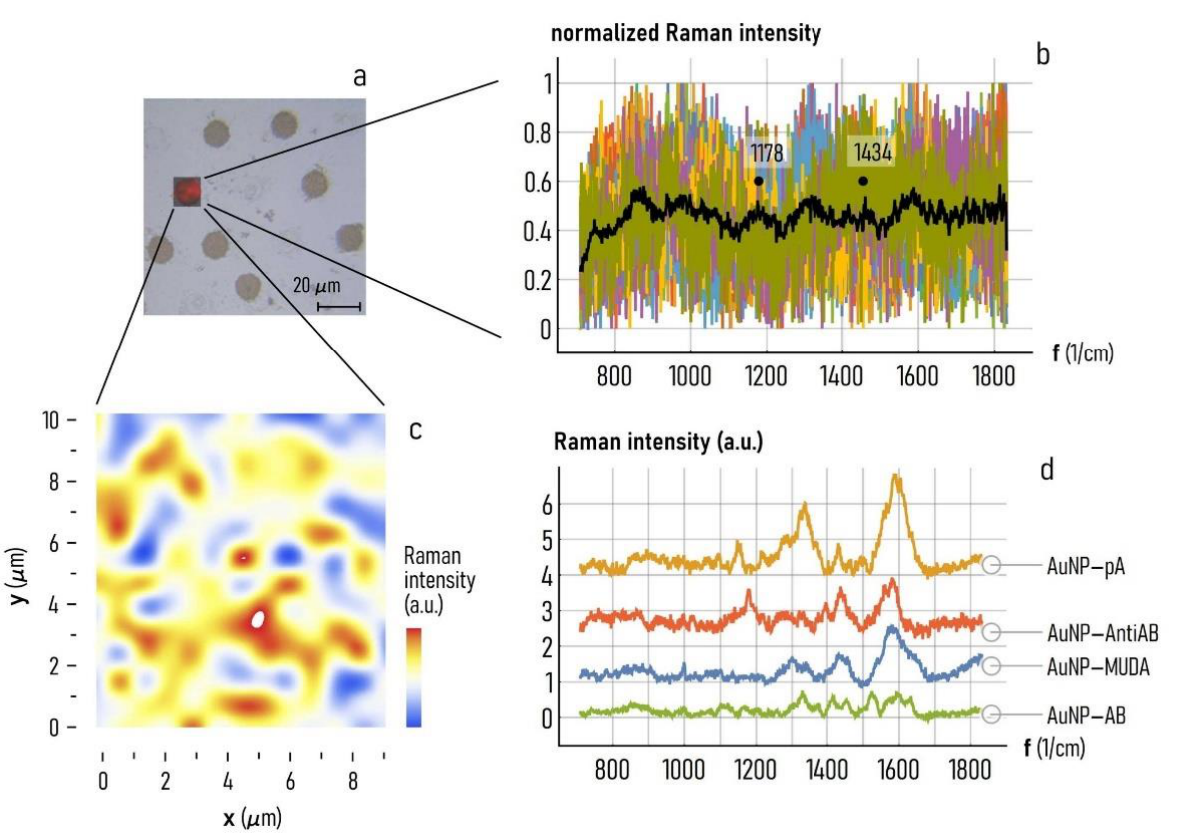
Figure 6. ( a ) Optical image of AuNP array template, analyzed by Raman spectroscopy. ( b ) Raman spectra collected during a mapping analysis. The averaged spectrum (black) evidence the two significative peaks at points 1178 cm − 1 (the histidine and tyrosine signal) and 1434 cm − 1 (CH 2 bending peak). ( c ) Map of distribution of the Raman intensity for the 1178 cm − 1 peak. ( d ) Raman spectra of the different functionalization steps.